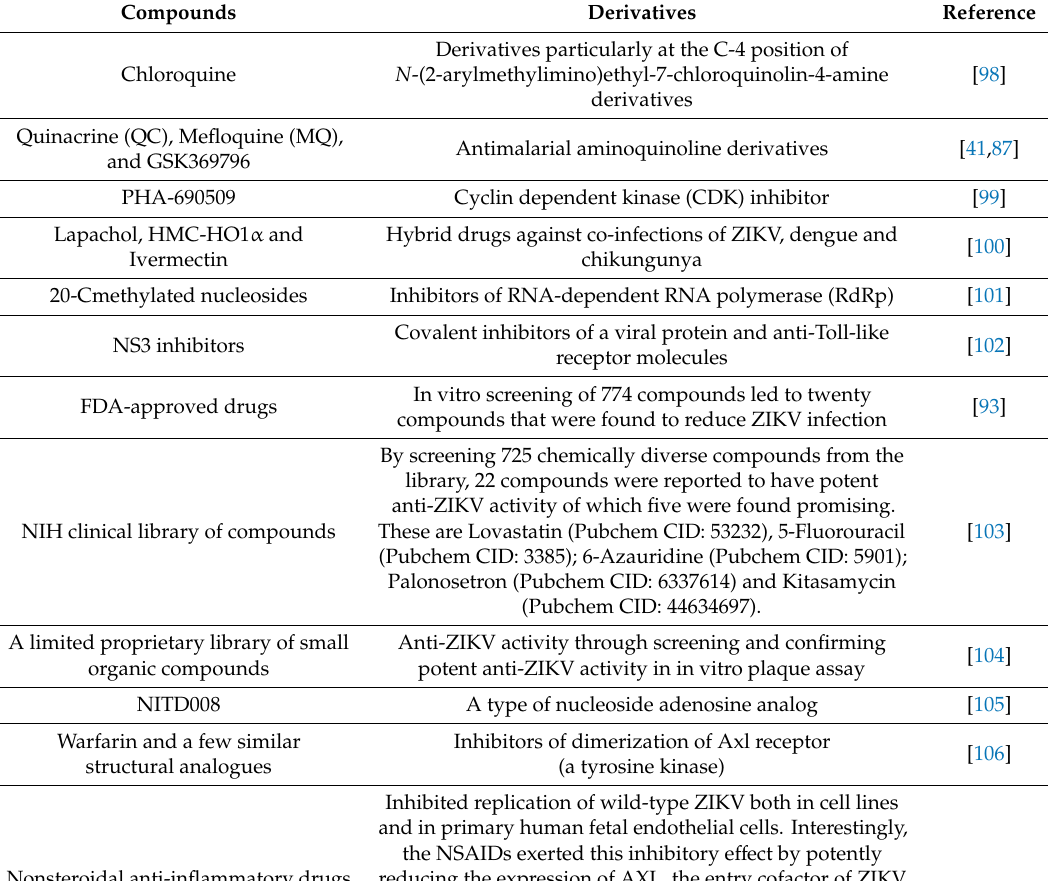
Table 6. Anti-ZIKV compounds having the potential to be